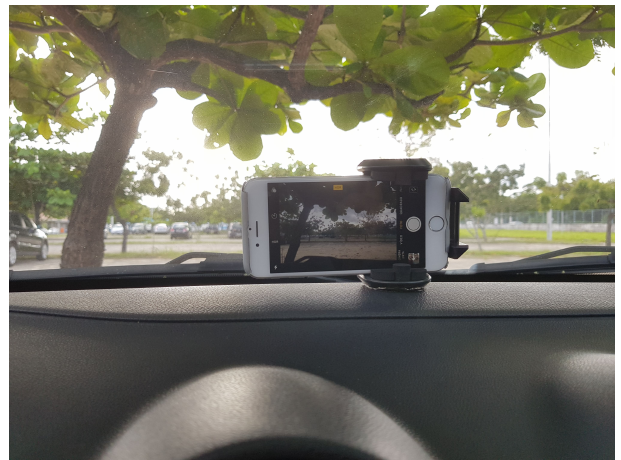
Figure 1. Traffic Light Recognition device support holding an iPhone 6.